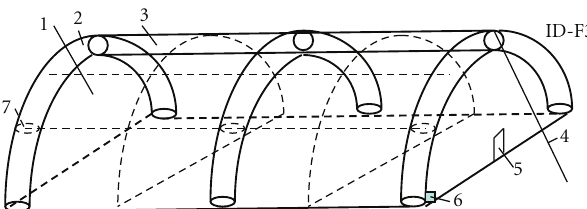
Figure 5: Semicircle film dome. Notations: (1) film dome; (2) semi- toroid tube; (3) connection inflatable tube; (4) bracing; (5) door; (6) air pumping, control station; (7) internal